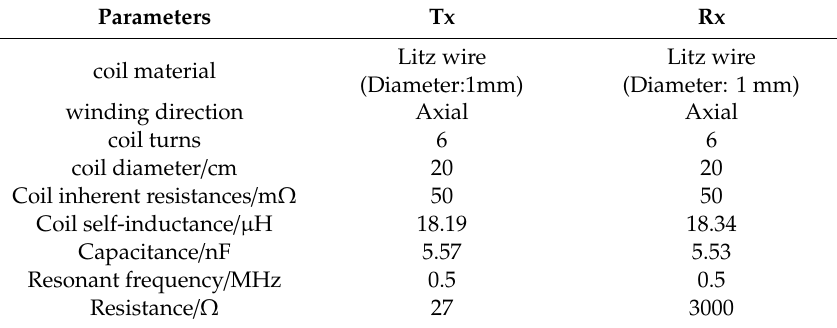
Figure 11. Experimental setup. Table 1. Experiment parameters of the system.